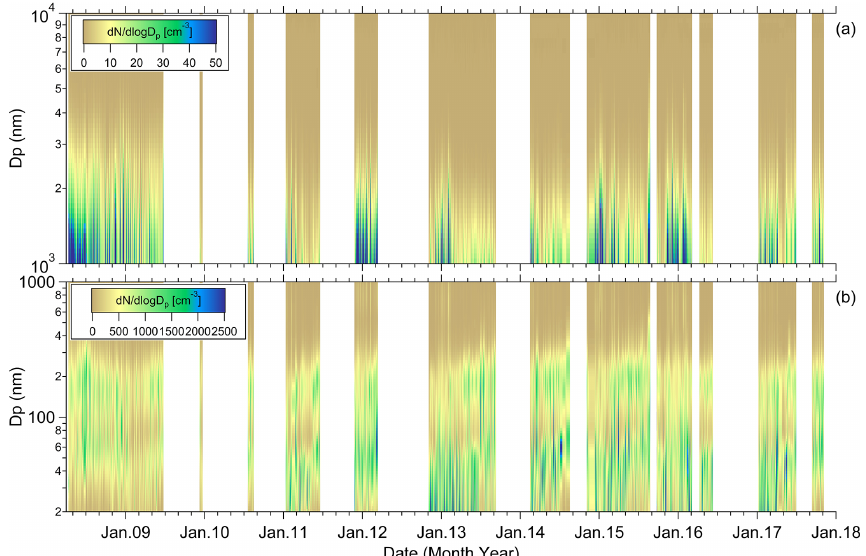
Figure 1. Contour plots of hourly averaged PNSDs in the supermicron size range (1000nm–10µm) in panel (a) and the submicron size range (20–1000nm) in panel (b) .